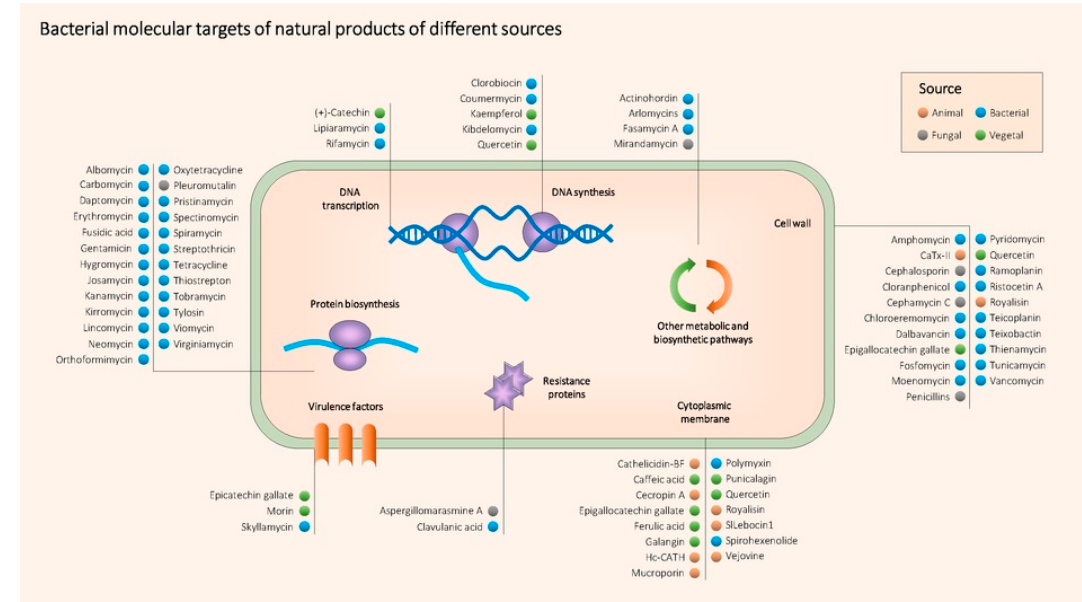
Figure 4. Main known molecular targets of antimicrobial NPs described in this review.